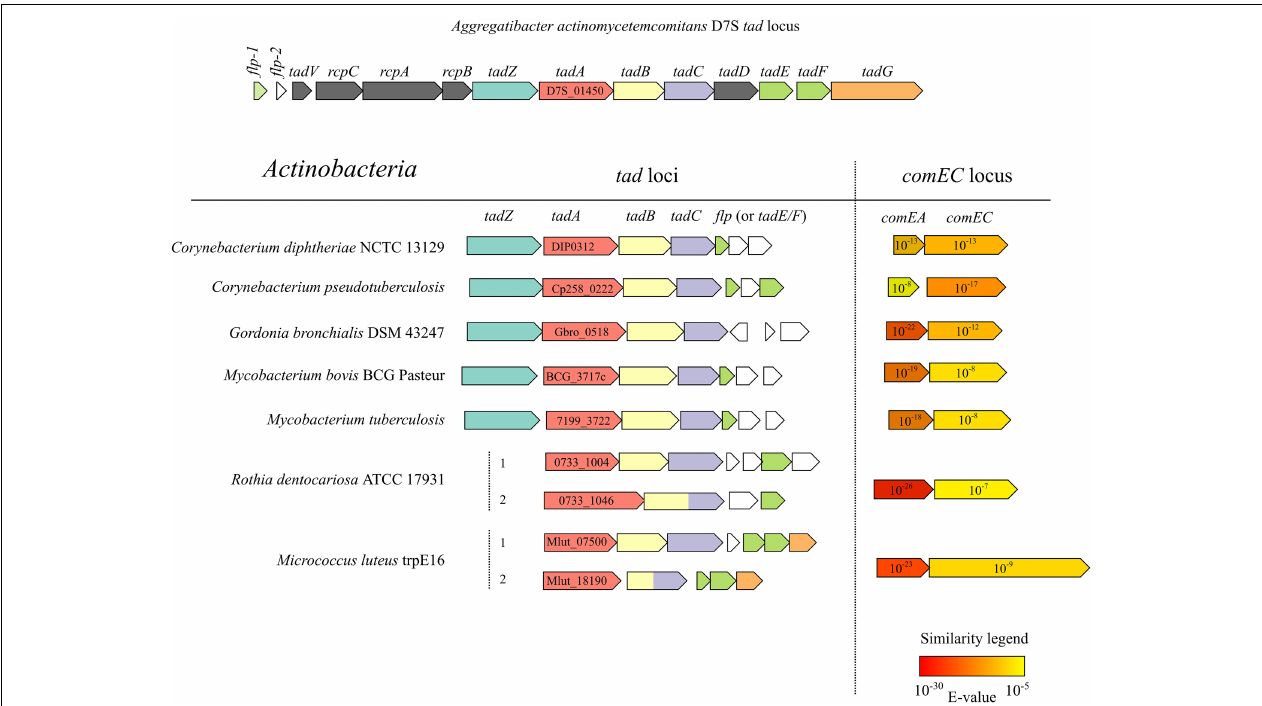
FIGURE 5 | Physical maps of tad and comEA/EC loci from the genomes of selected actinobacterial representatives (high-GC Gram-positive) and of the prototypical tad locus of A. actinomycetemcomitans. ORFs of the same color encode proteins with significant similarity (BLAST E < 10 − 6 ) to the respective tad gene